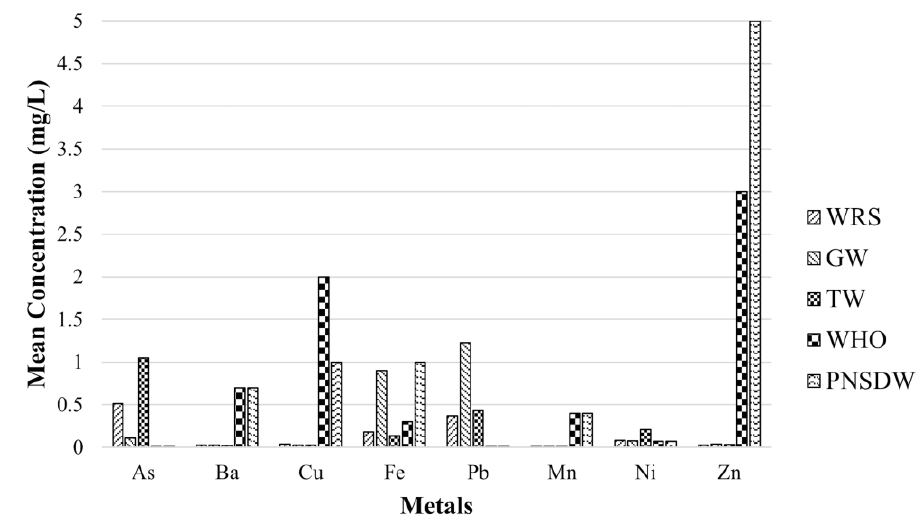
Figure 3. Average HMM concentrations in all DW samples.